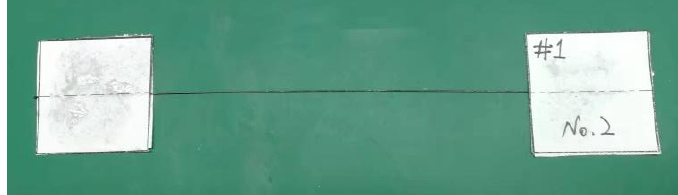
Figure 5. Preparation of CFRPF monofilament tensile samples.